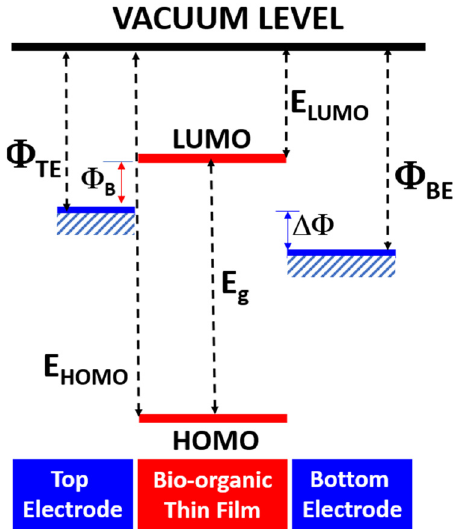
- organic thin fi lm sandwiched between top and bottom electrodes; the respective symbols and abbrevia - tions used are explained in the main